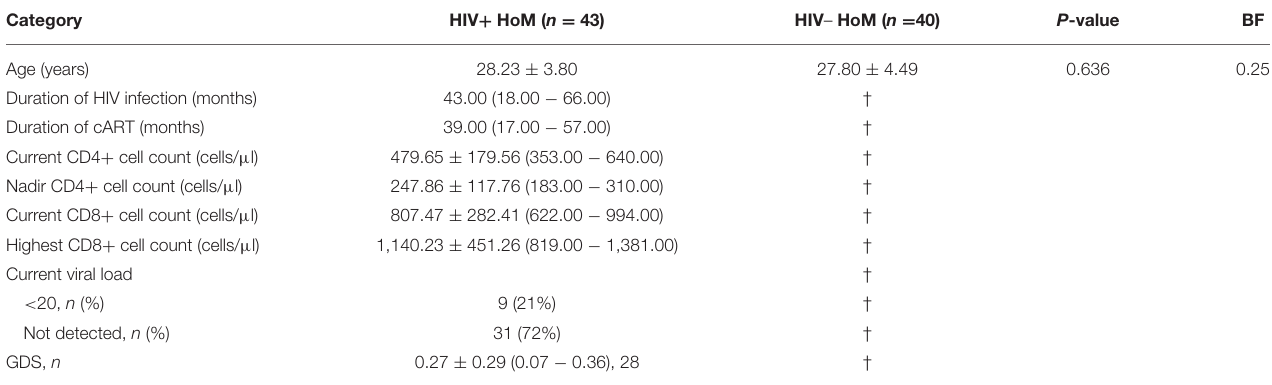
TABLE 1 | Demographics, clinical information, and neurocognitive performance of HIV + HoM and HIV– HoM.